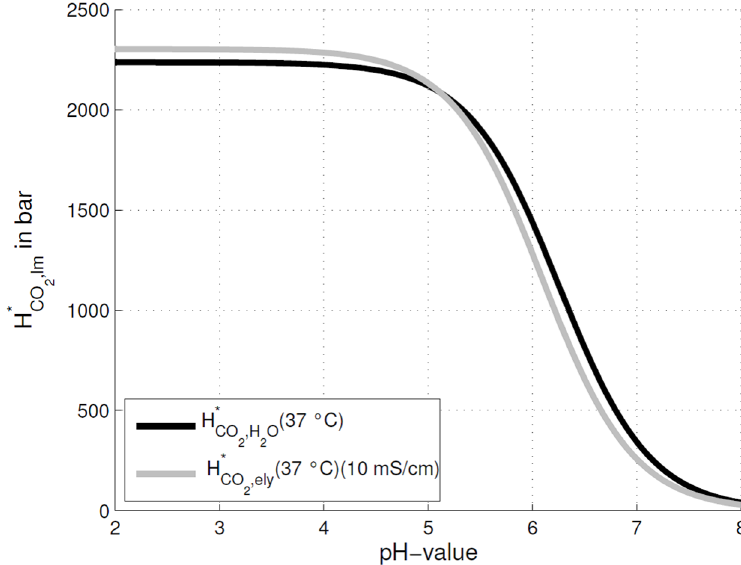
Figure 2. Apparent Henry coefficient for carbon dioxide in water and in a solvent with electric conductibility of 10 mS·cm − 1